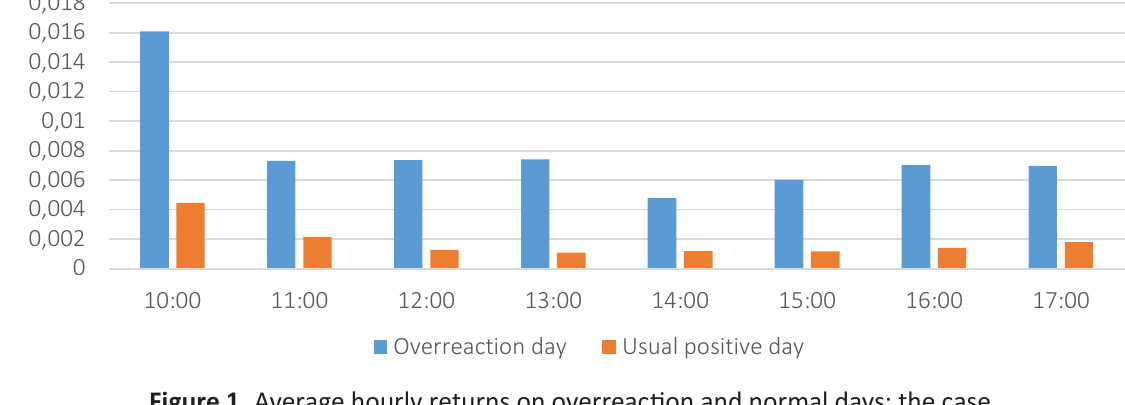
Figure 1. Average hourly returns on overreaction and normal days: the case of positive overreactions, UX-C